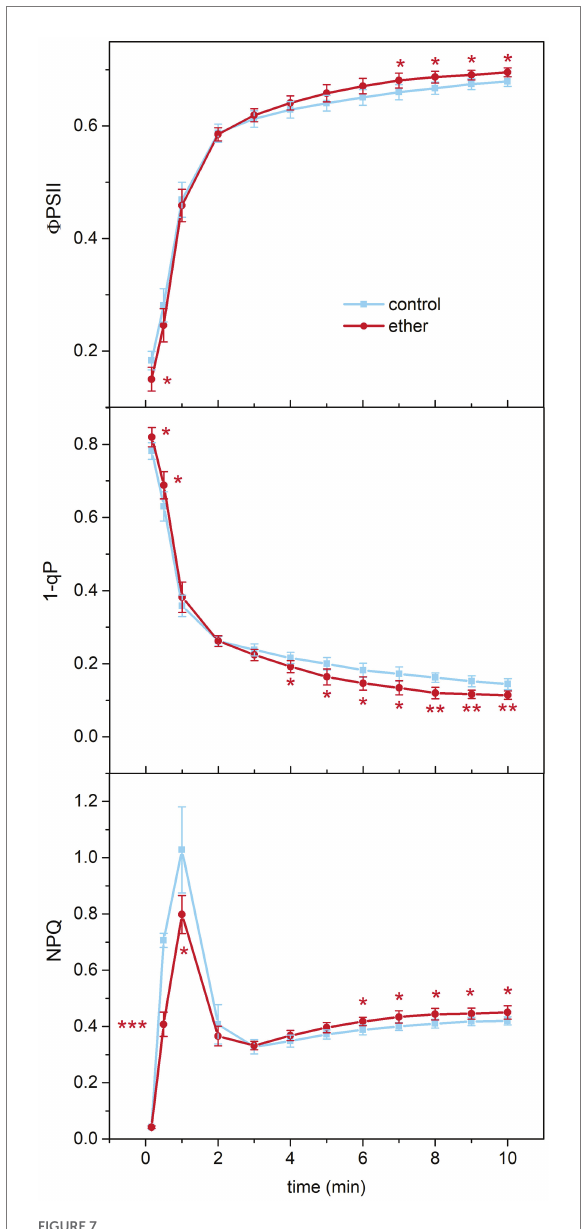
FIGURE 7 Chlorophyll a fluorescence parameters in Arabidopsis thaliana . A kinetics of effective photochemical quantum yield of PSII ( Φ PSII ), excitation pressure on PSII (1–qP), and non-photochemical quenching (NPQ) of chlorophyll a fluorescence after switching on actinic light (time point 0 min) in control and etherized plants. Asterisks denote significant difference at p < 0.01 (**) and p < 0.05 (*), (Student t -test). Means ± SD, n = 5 (Student’s t